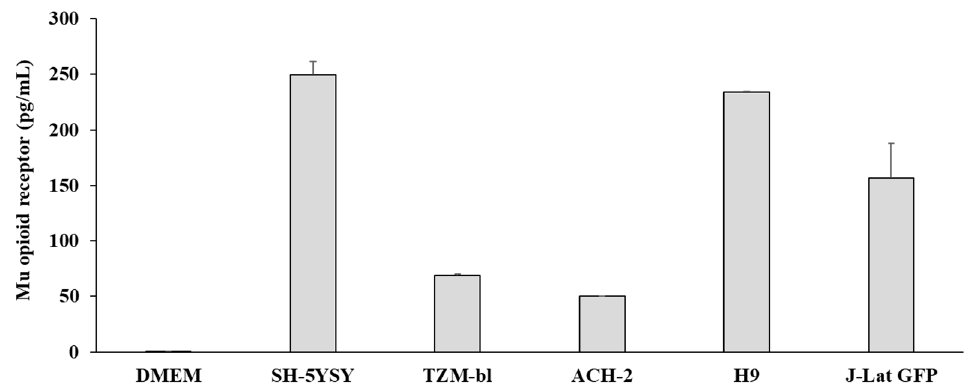
Figure 1. Expression of mu opioid receptor was quantified with ELISA in ~1 × 10 5 cells. DMEM = Dulbecco’s Modified Eagle Medium (DMEM). Error bars denote standard deviation of three independent experiments.